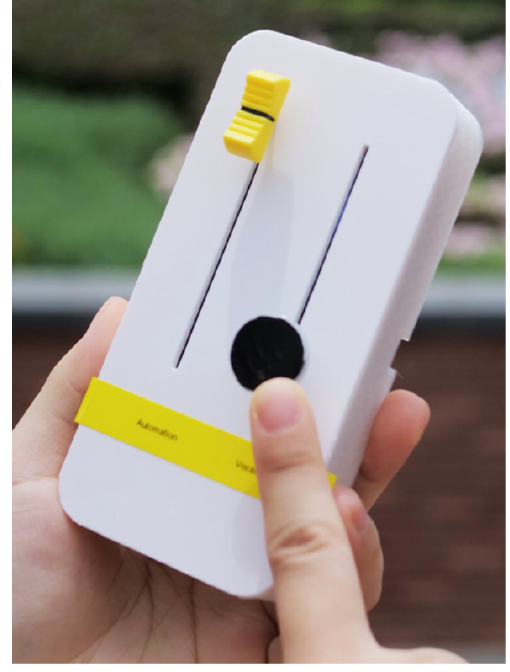
Figure 1. Appearance prototype of The Regulator. The following paragraphs present four hypothetical use scenarios for The